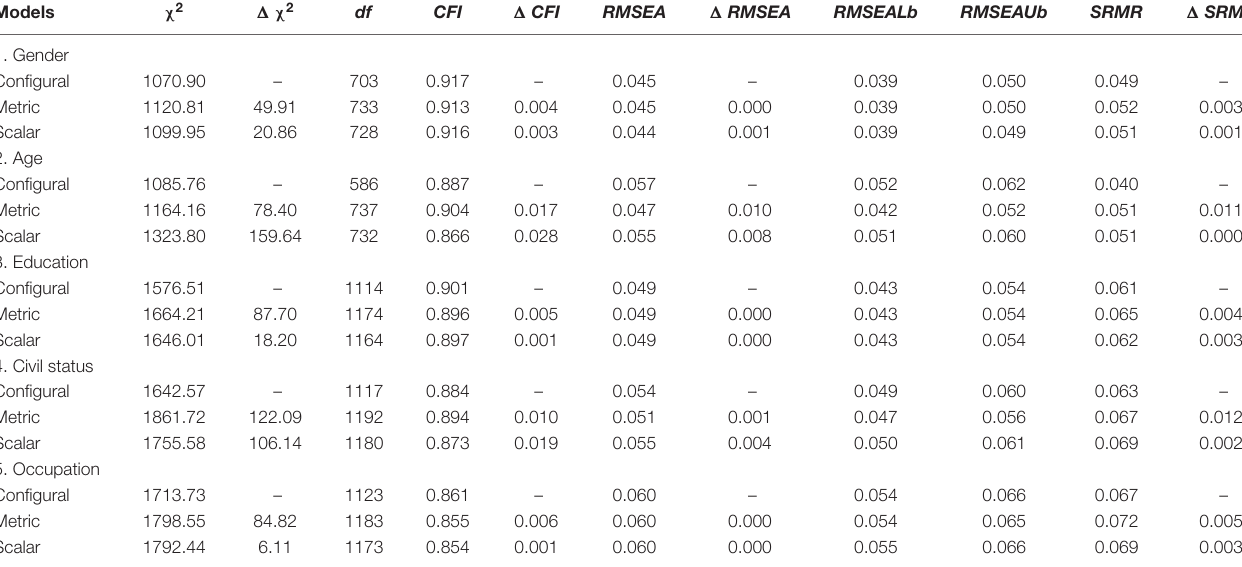
Model 1 = gender, N = 528, nWomen = 280, nMen = 248. Model 2 = age, N = 528, nYoung = 230, nSenior = 298. Model 3 = education, N = 528, nSecondary = 187, nUniversity = 257, nGraduate = 84. Model 4 = civil status, N = 479, nSingle = 273, nRelationship = 118, nMarried = 88. Model 5 = occupation, N = 438, nPrivate = 164, nPublic = 114, nStudent = 160. χ 2 = chi squared, (cid:49) χ 2 = chi squared difference, df = degrees of freedom, CFI = comparative fit index, (cid:49) CFI = CFI difference, RMSEA = root mean square error of approximation, (cid:49) RMSEA = RMSEA difference, RMSEALb = RMSEA lower bound, RMSEAUb = RMSEA upper bound. SRMR = standardised root mean residual, (cid:49) SRMR = SRMR